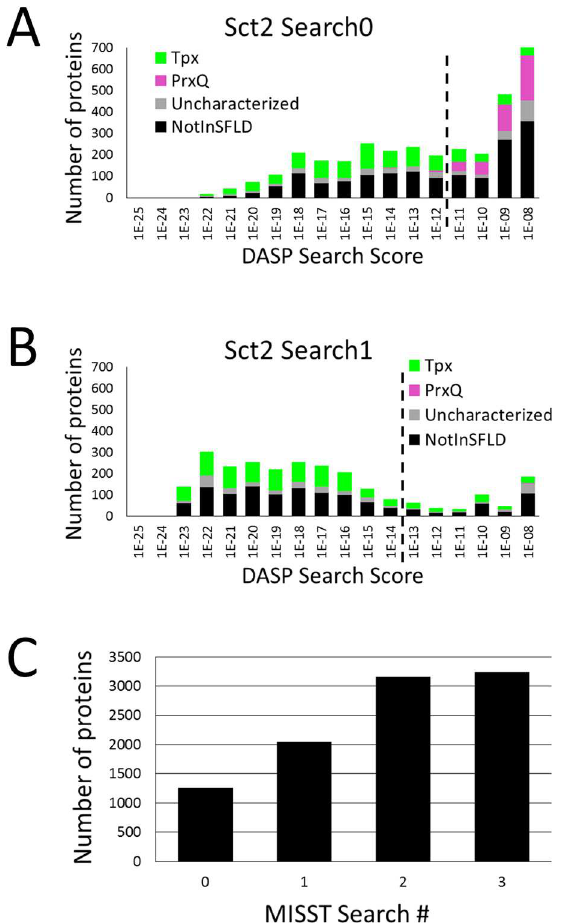
Fig 7. Agglomeration of Tpx sequences and loss of PrxQ sequences in Sct2_Tpx during MISST search iterations. The proteins identifiedin Sct2_Tpx Search0 (A) and Search1 (B) are displayedas histograms with bars coloredto show previouslyknown functionalgroups. Dotted black lines signify the DASP search score threshold of (cid:20) 1e-12for Search0 and (cid:20) 1e-14 for Search1. (C) The numberof total proteins identifiedby Sct2_Tpx at significantDASP2 search scores is shownfor searches0 through